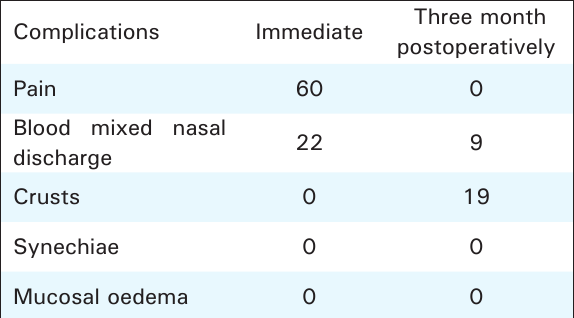
Table 2. Frequency of postoperative morbidities at three months follow